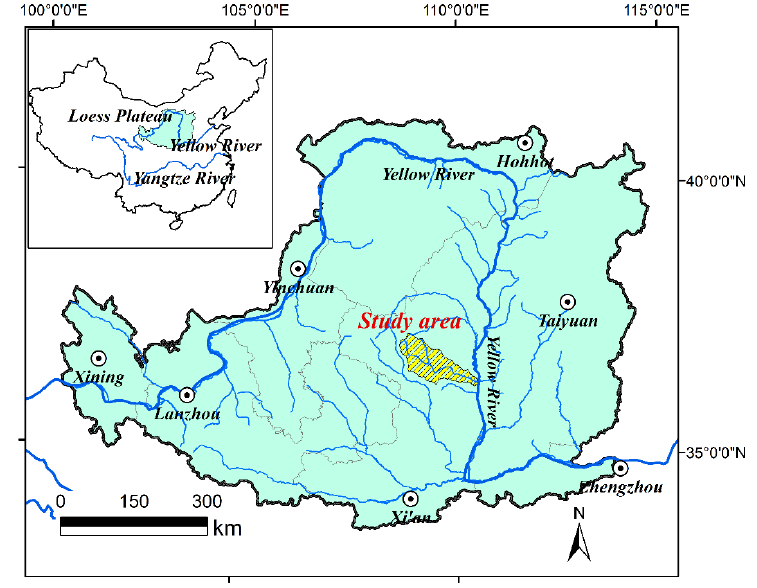
Figure 1. Location of the Yanhe river catchment in the Loess Plateau, China.